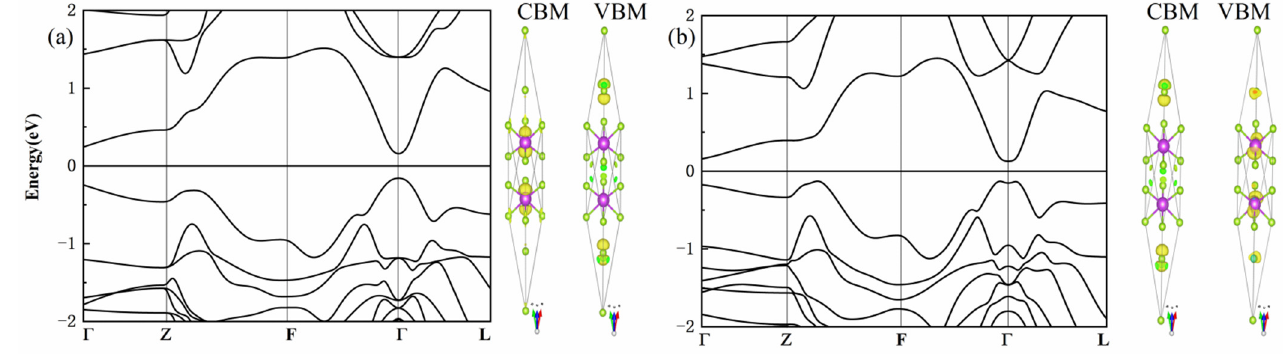
Figure 2. Band structure and partial charge of Bi 2 Se 3 : ( a ) GGA and ( b ) SOC.